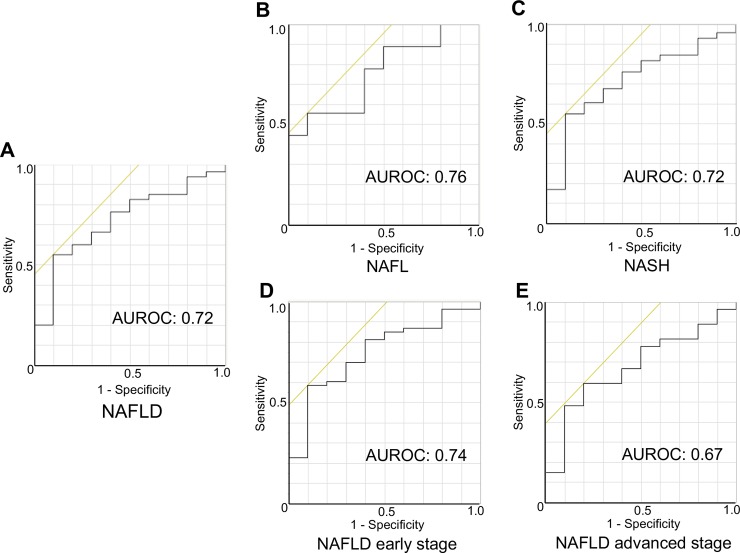
Receiver operating characteristic (ROC) curve analysis.ROC curves for serum miR-379 expression level for the diagnosis of NAFLD (A) and NAFLD subgroups (B: NAFL, C: NASH, D: NAFLD early stage and E: NAFLD advanced stage). Serum miR-379 expressions were normalized to that for serum miR-16. NAFLD early stage was defined as Brunt fibrosis stage 0 or 1, and advanced stage was defined as Brunt fibrosis stage 2 to 4. AUROC means area under the ROC curve.